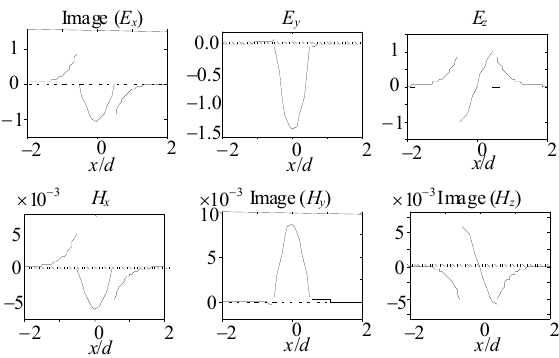
Fig. 5 Field profiles at mode.